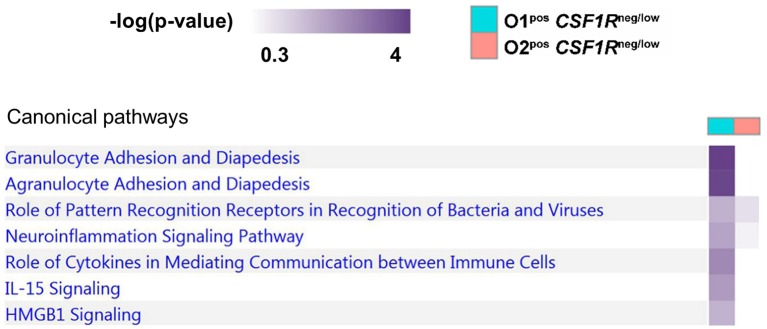
Pathway analysis of APEC O1-GFP vs. APEC O2-GFP infected CSF1R-tgneg/low cells based on DEGs between the two populations (log fold-change). Stronger coloring indicates enrichment of genes associated with the given pathway.